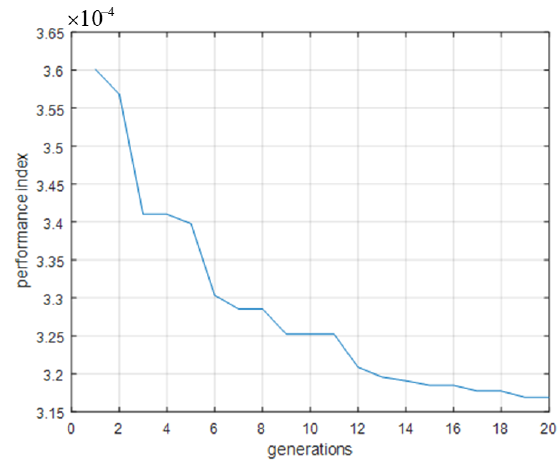
Figure 8. The performance index curve with respect to generations. The step responses of the load current i R and the inductor current i L in the closed-loop system using the designed PI controller’s parameters via GA are shown in Figure 9a,b, respectively. As can be seen, the inductor current response is smoother than the load current in the transient state, and both achieve the steady-state value without error.